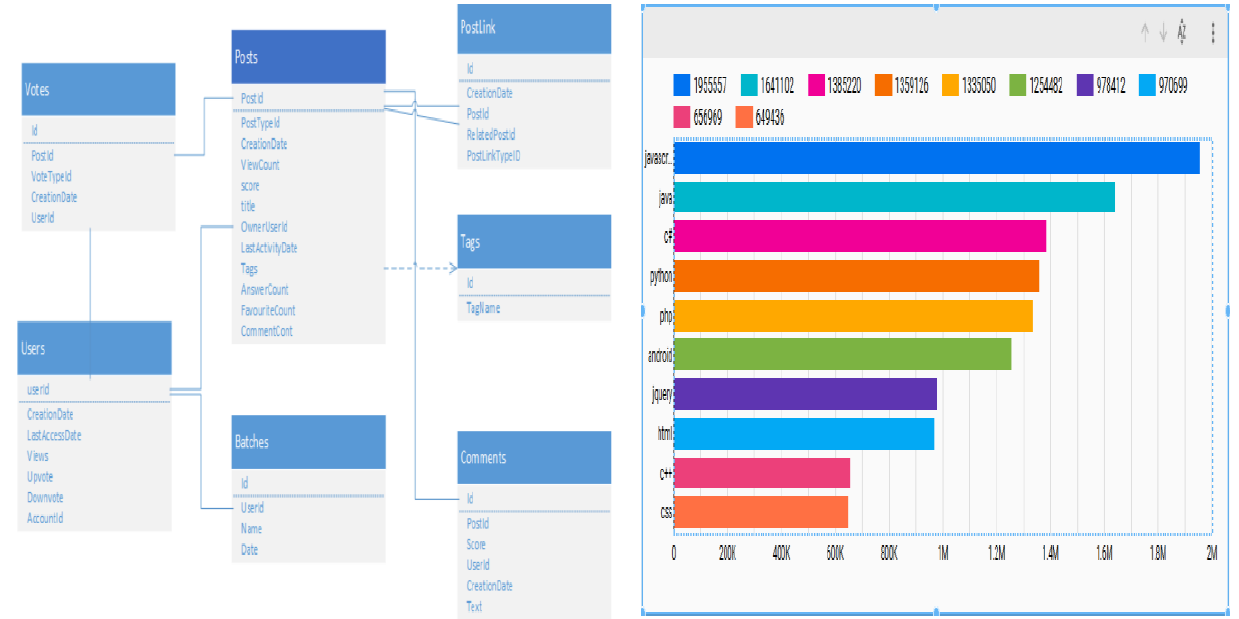
Figure 1. Stack overflow Dataset tables